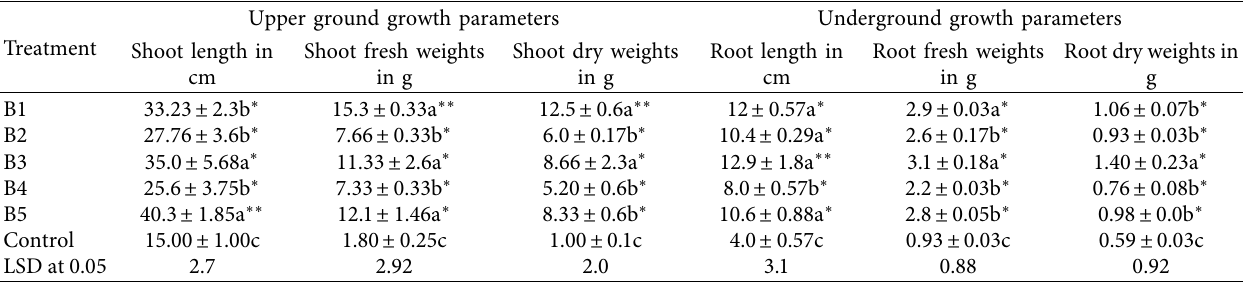
Table 3: The effect of Bacillus isolates on the growth of tomato variety Melkesalsa seedlings.